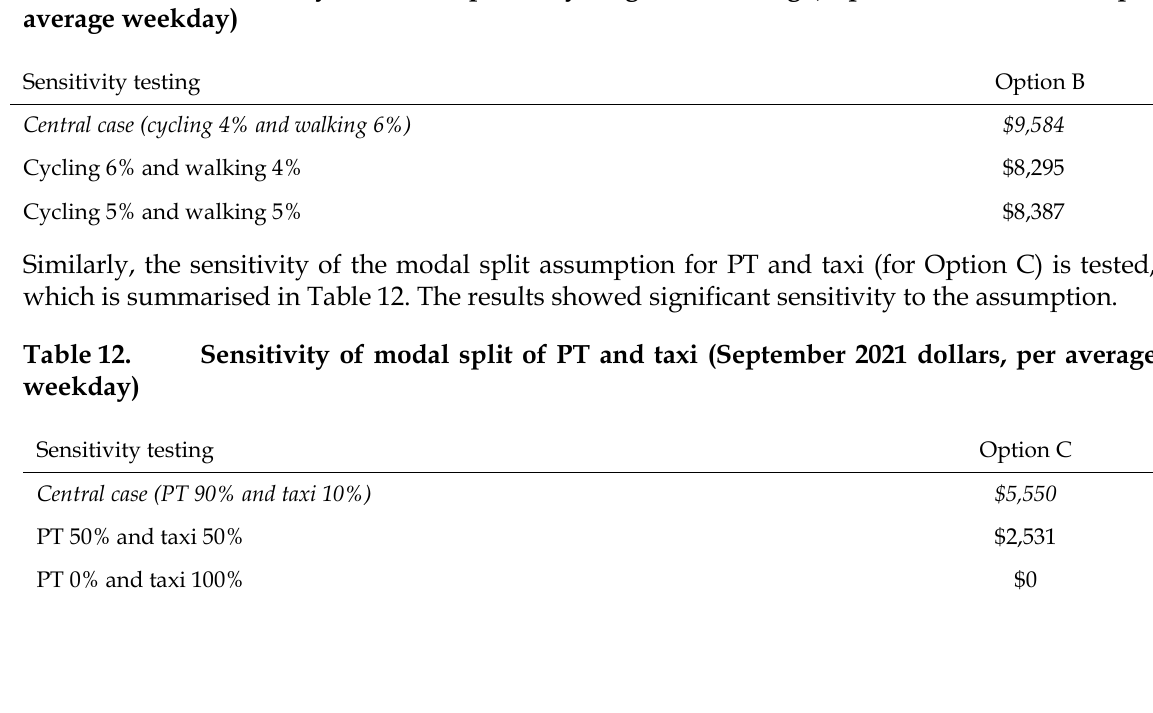
Sensitivity of modal split of cycling and walking (September 2021 dollars, per